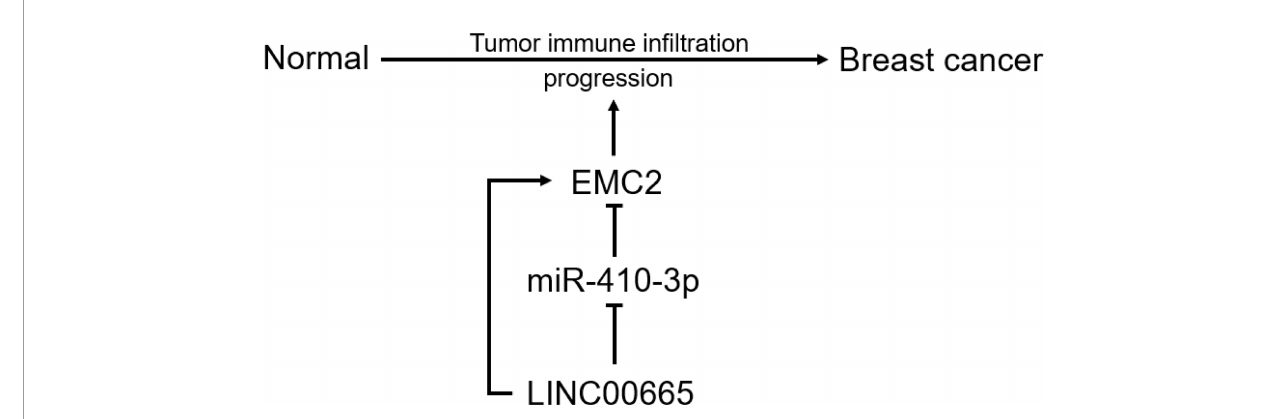
FIGURE 9 | The model of LINC00665-niR-410-3p- EMC2 axis in carcinogenesis of